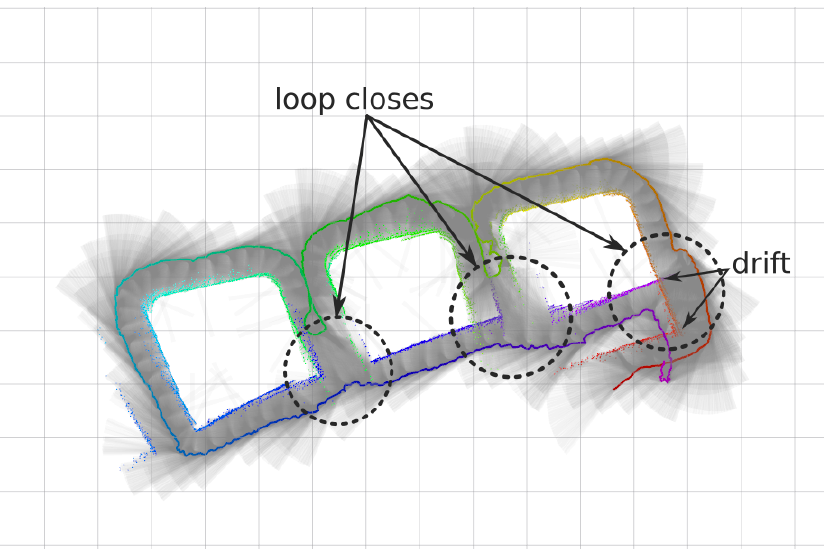
Figure 9. DR trajectory in a continuous line from magenta to red, with the corresponding profiler rays (in black) and their hitpoints (also colored by time) of the breakwater dataset. Grid cells at the background are 5 m